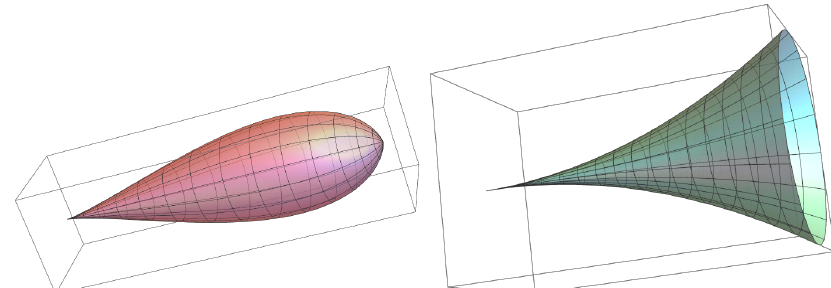
Figure 3 . Cartoons of a black bottle (left) and a black goblet (right). For the black bottle, the right end-point is a R 2 / Z k singularity. The left end-point is cusp metric: this pole is infinitely far from the other pole but the volume is finite. For the black goblet, the right side is a circle and the left end-point is cusp